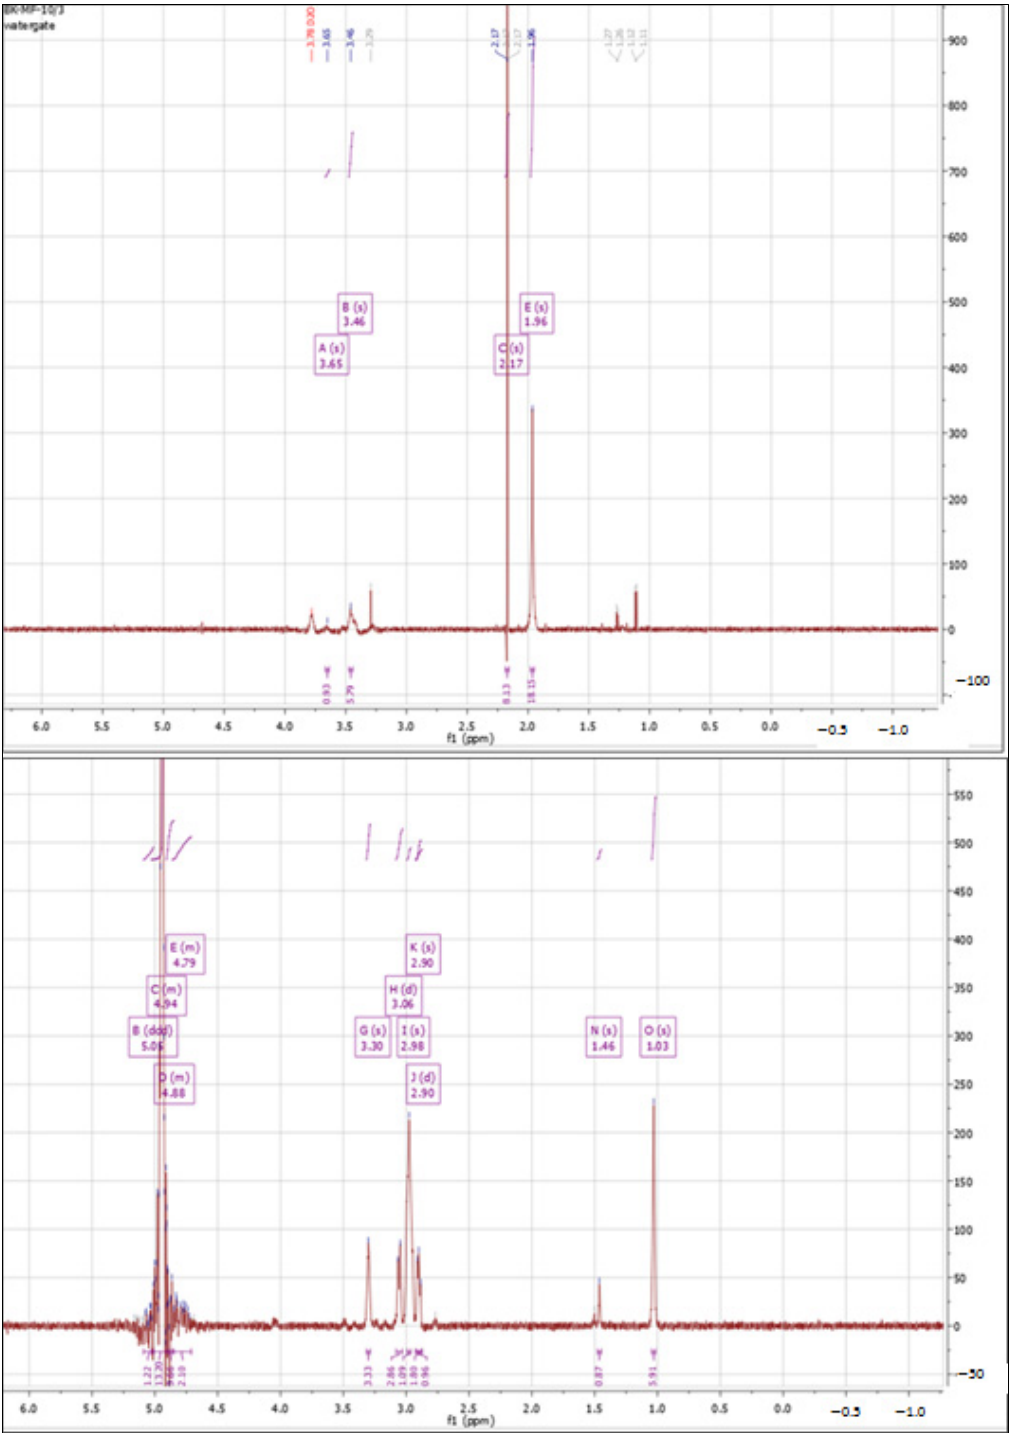
Figure 6. 1 H NMR spectra of native HA ( top ) vs. HA cross-linked with BDDE ( bo tt om ).